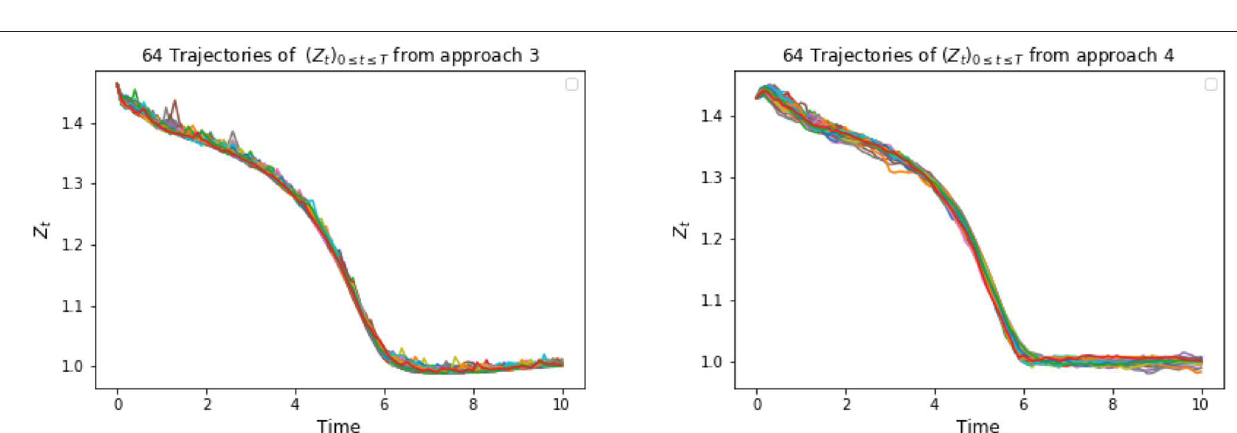
) t based on approach 3 (on the left) and approach 4 (on the right). i 0 ≤ t i ≤ t N